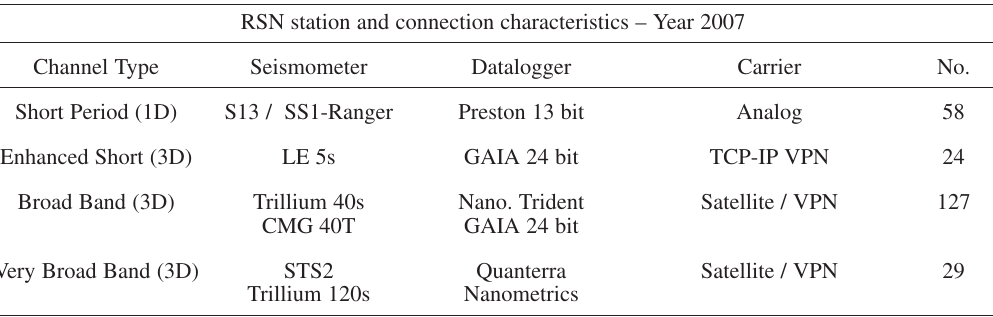
Table II. Numbers (last column) and characteristics of the RSN at the end of 2007, divided by sensor type (first column). All the stations are continuously connected in real time with the INGV centre in